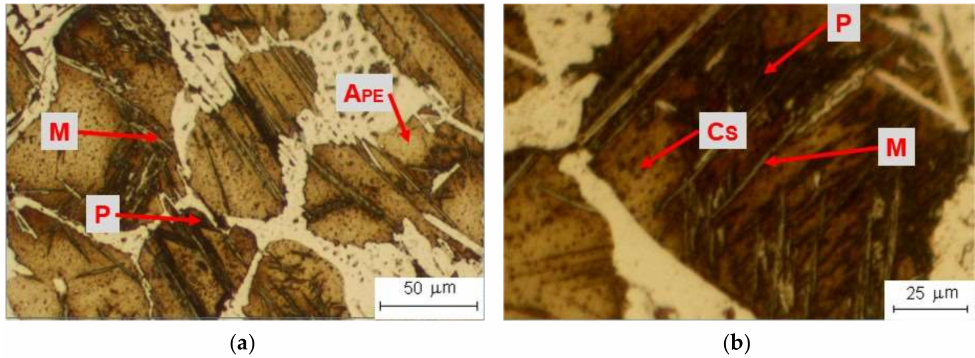
Figure 10. Marble reagent at room temperature: ( a ) general view at 200 × ; ( b ) detail at 500 ×